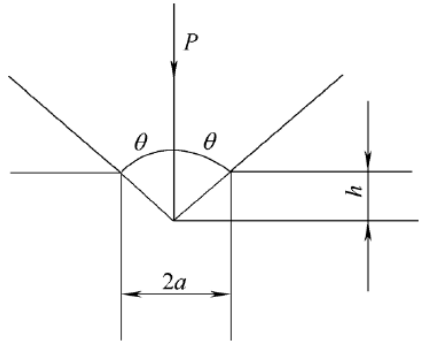
Figure 2. Schematic diagram of abrasive indentation.